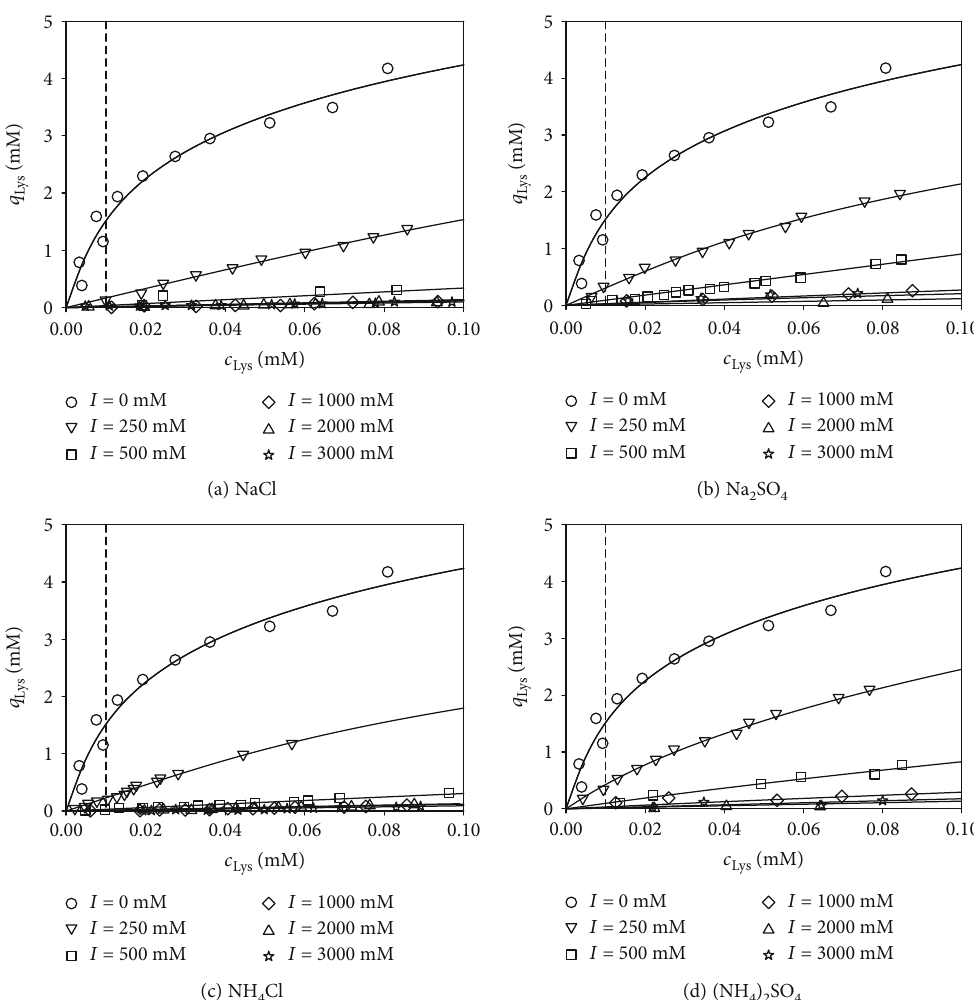
Figure 1: Experimental equilibrium adsorption isotherms (symbols) of lysozyme on Toyopearl MX-Trp-650M at pH 7.0 and 25 ° C for di ff erent ionic strengths I of (a) sodium chloride, (b) sodium sulfate, (c) ammonium chloride, and (d) ammonium sulfate and corresponding individual correlations (lines), cf. Equation (1). Data for I = 1500 mM and I = 2500 mM, which were also measured in the present work, are not depicted here for improved